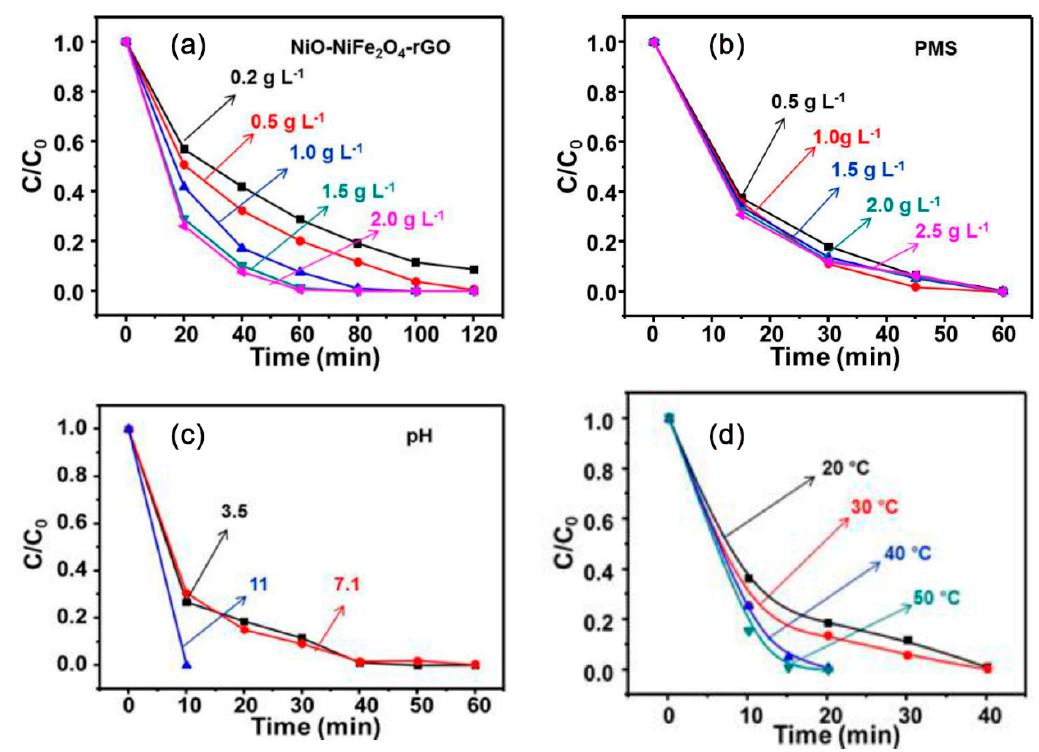
Figure 7. Effects of ( a ) NiO-NiFe 2 O 4 -rGO dosage, ( b ) peroxymono-sulfate (PMS) dosage, ( c ) initial pH, and ( d ) temperature on the degradation of RhB.